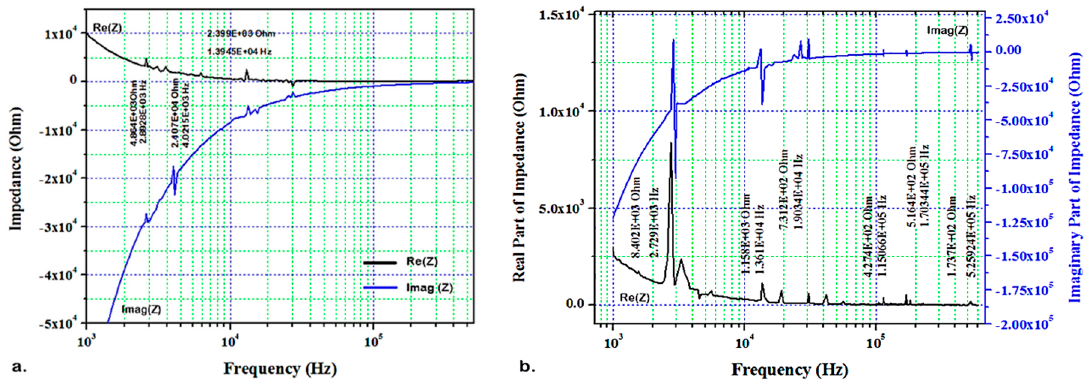
Figure 7. Real and imaginary EMI for the blade L 2 , frequency sweep at 1–600 kHz using transceiver board at 20 °C; ( a ) pristine blade and ( b ) damaged blade.